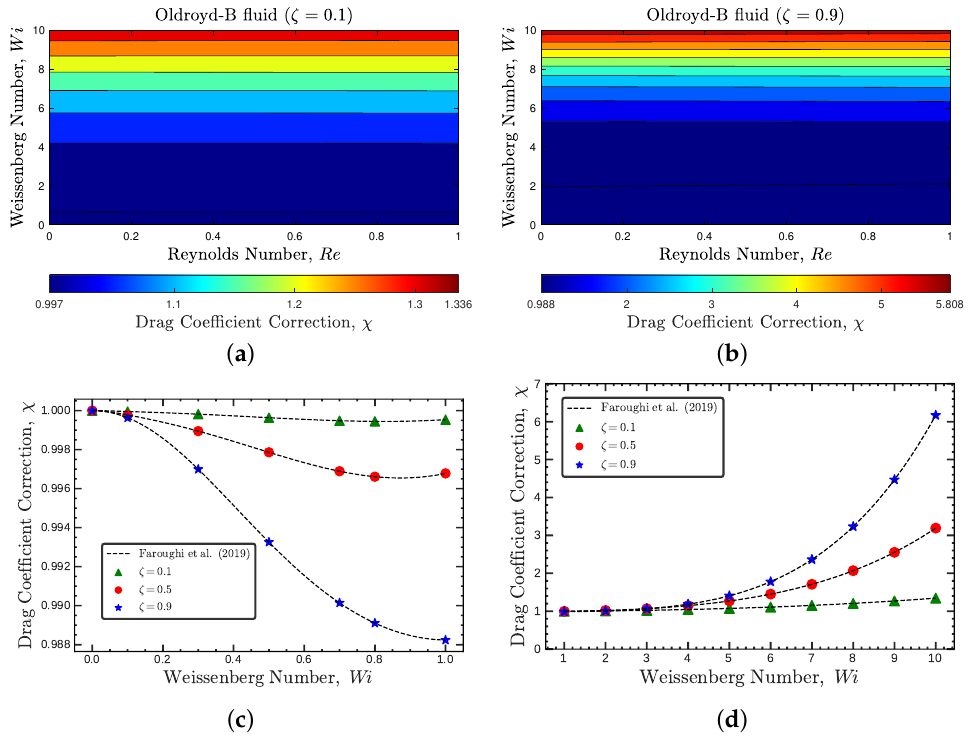
Figure 3. Contours of the viscoelastic drag coefficient correction, χ , for the Oldroyd-B fluid at 0 < Re ≤ 1, 0 ≤ Wi ≤ 10 and ( a ) ζ = 0.1 and ( b ) ζ = 0.9. Panels ( c , d ) show the variation of χ with Weissenberg numbers for different values of ζ at Re =